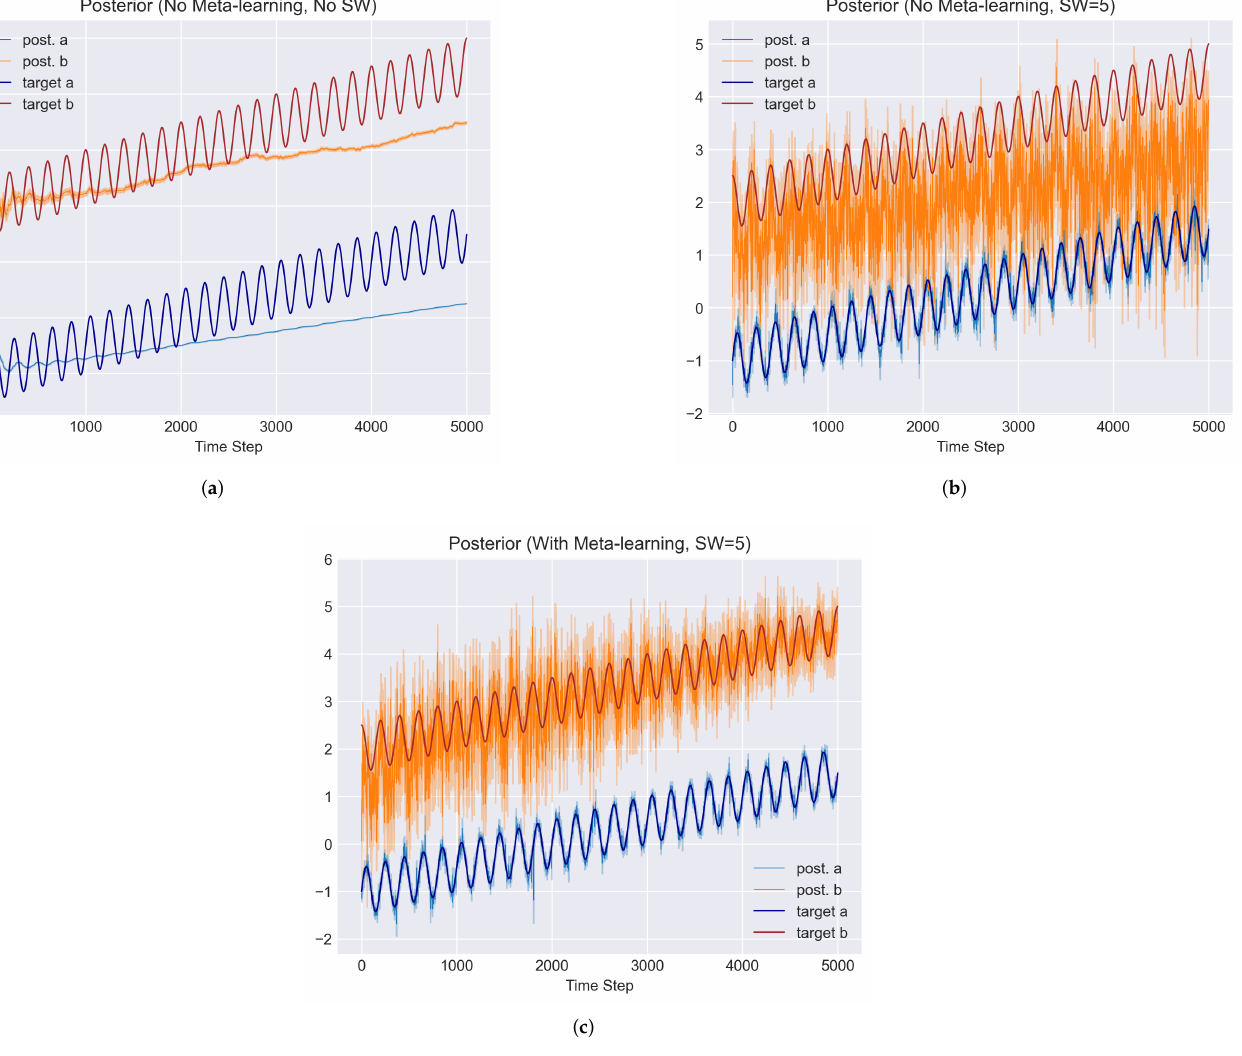
Figure 3. Posterior distributions for parameters a and b over time steps. The dark blue and red lines are for the true a and b values. The light blue and orange lines show the mean of the posterior distributions, and shaded areas are for the std. range. ( a ) No meta-learning, no sliding window; ( b ) no meta-learning, sliding window = 5; ( c ) meta-learning, sliding window =